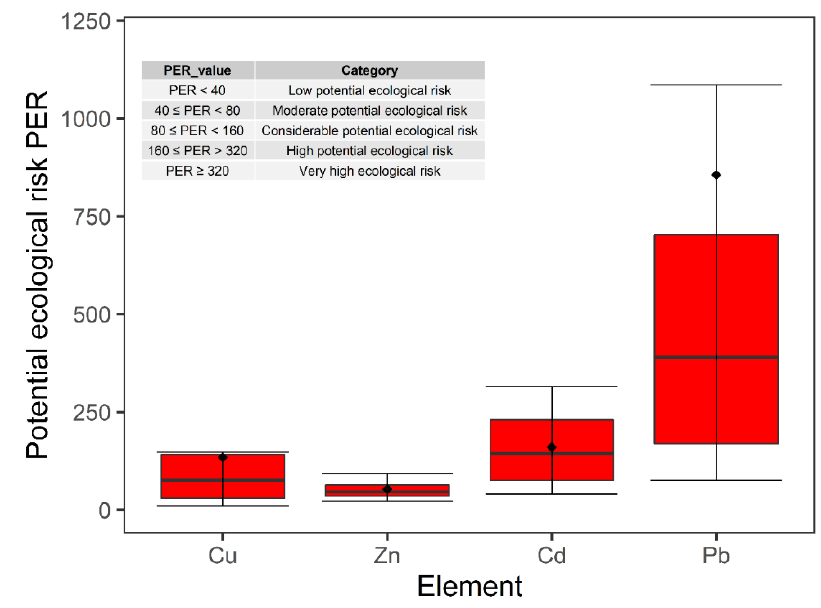
Figure 7. PER and the corresponding range for each category.